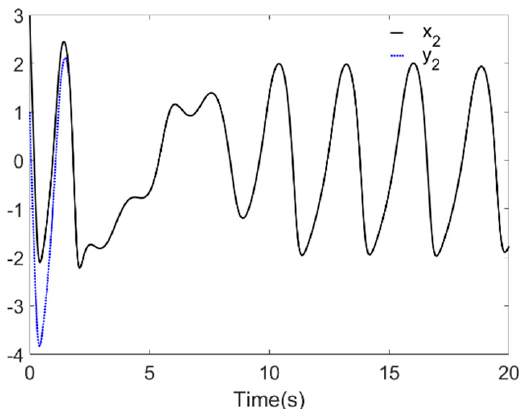
Figure 5. Synchronization process of y 2 arrives x 2 .